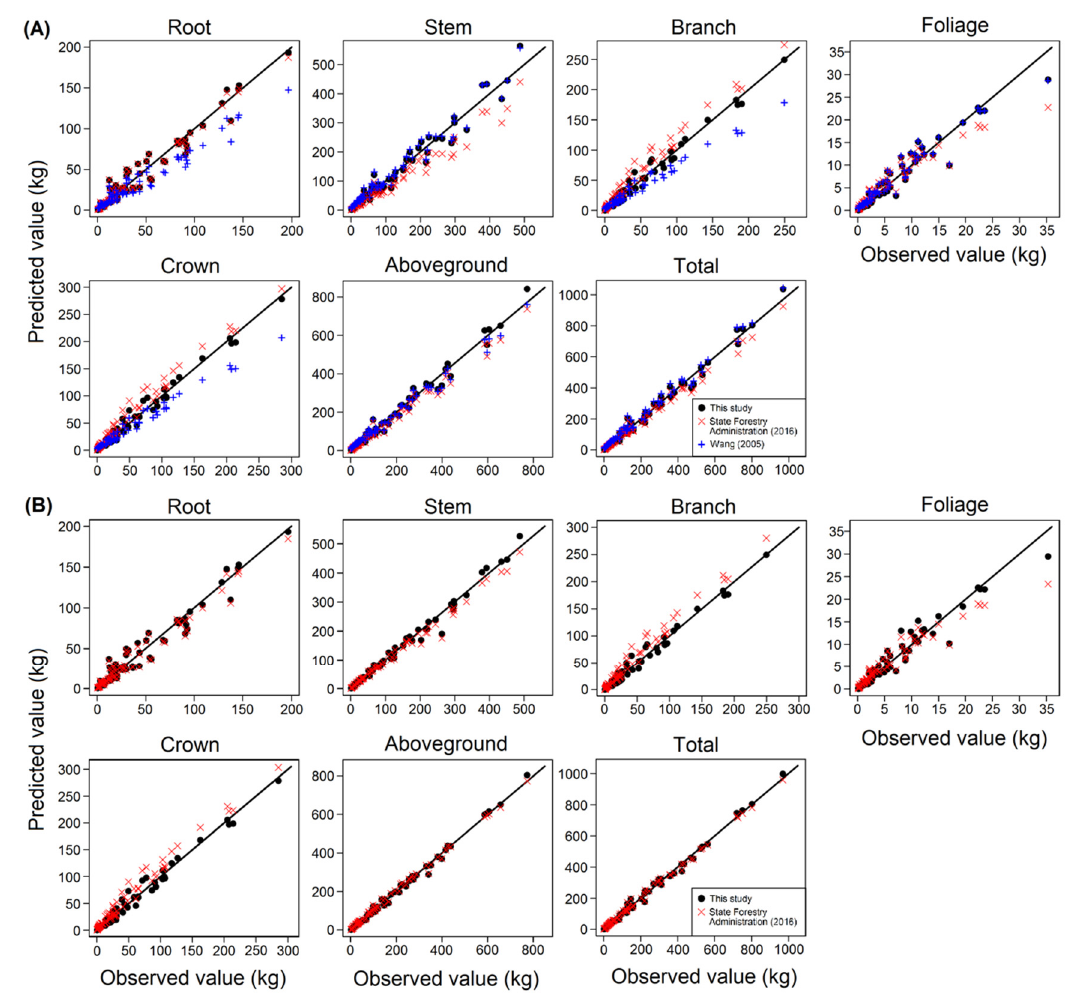
Figure 5. Total, subtotal, and component biomass models from present study compared to equations from previous studies based on different predictors for Mongolian oak: ( A ) D only and ( B ) D and H.